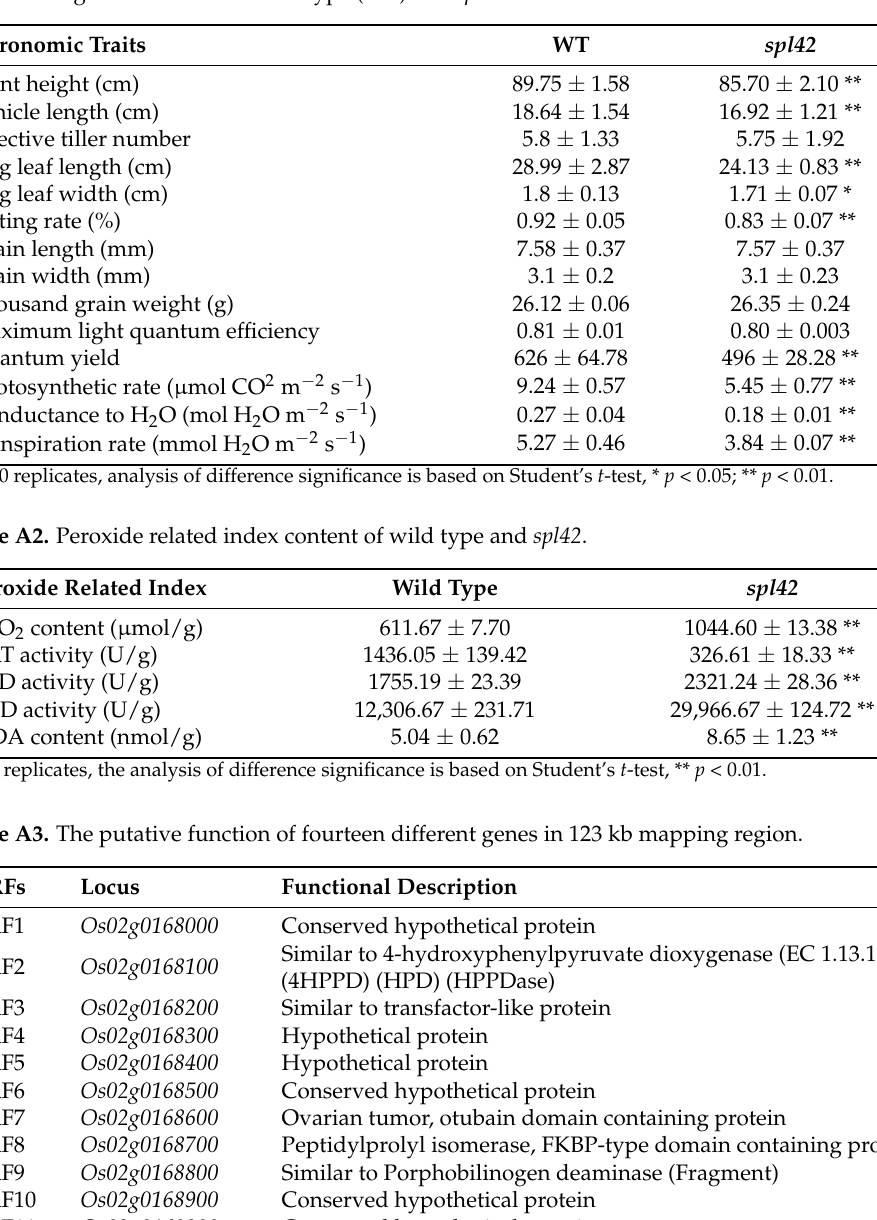
Table A1. Agronomic traits of wild type (WT) and spl42 .